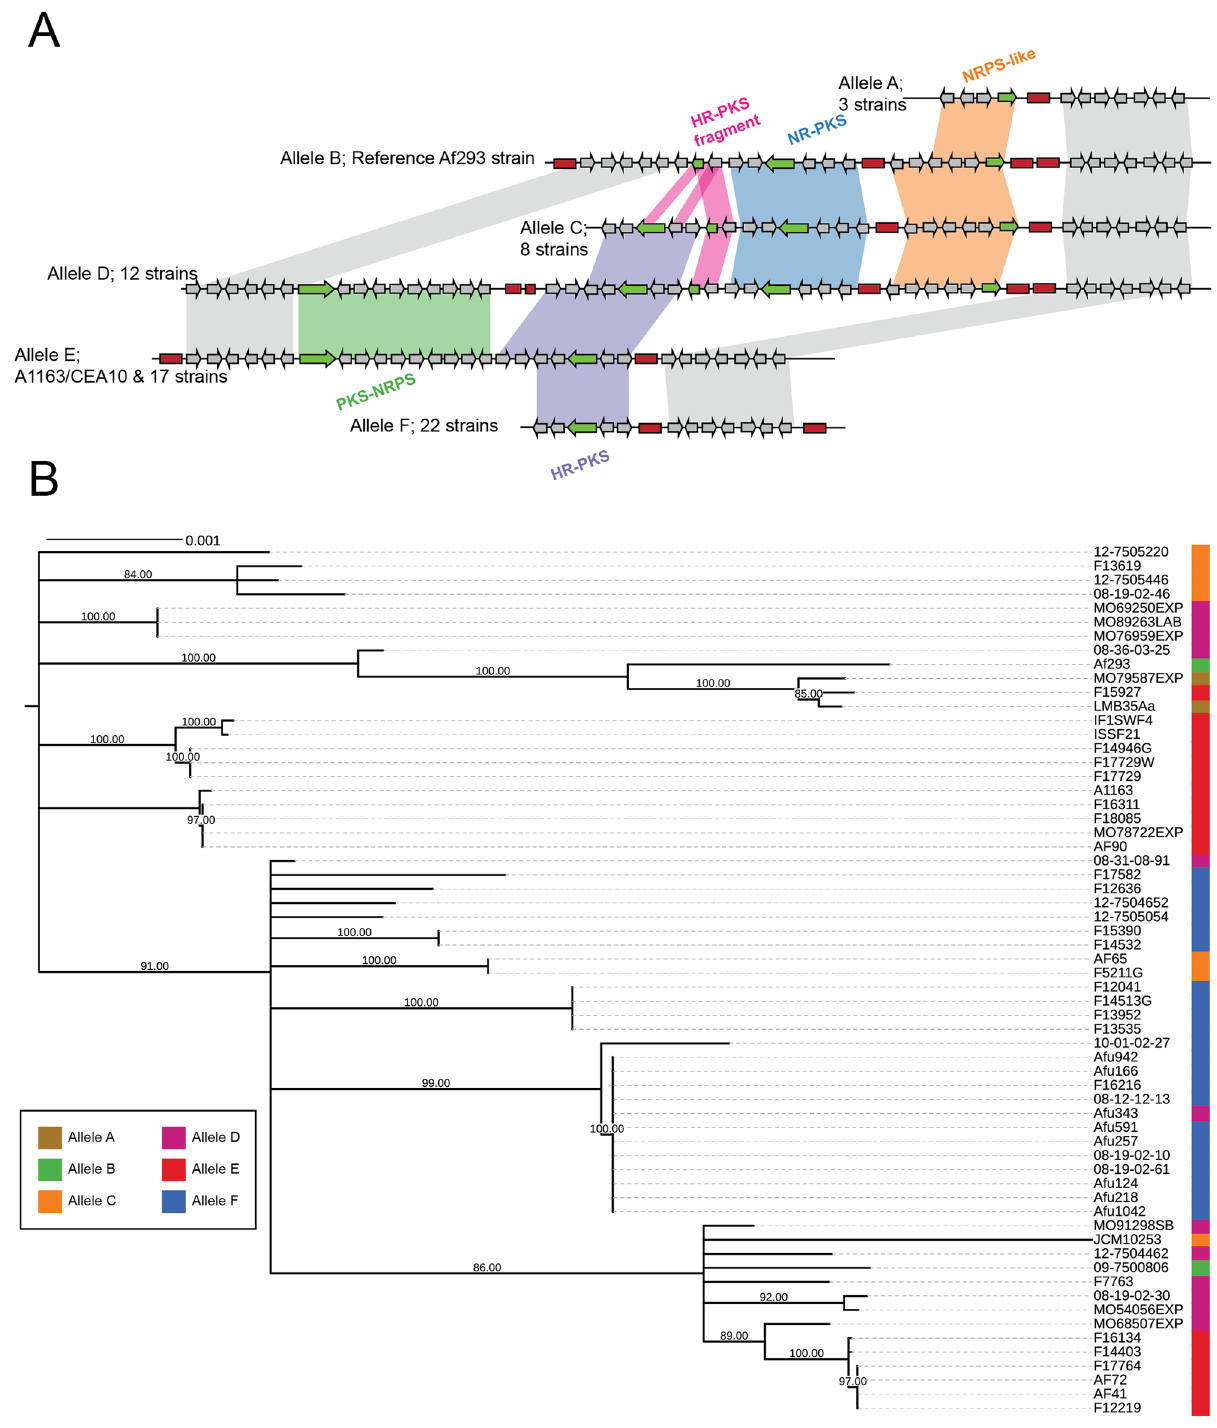
Fig 4. Six alleles of an idiomorphic SM gene cluster. (A) Alleles of SM gene cluster 10 on chromosome 3. Red boxes denote transposable elements. Green arrows denote backbonegenes(PKS or NRPS). (B) Locus phylogenyof conserveddownstreamof the idiomorphcluster (highlightedin gray in [A]). Phylogenywas constructed using a 48-mb nucleotide alignmentwith the GTRGAMMA model and midpoint rooted. Branches with bootstrapsupport < 80% were collapsed. HR, highly reducing;NR, nonreducing;NRPS, nonribosomal peptidesynthase; PKS, polyketidesynthase; SM, secondary metabolite.